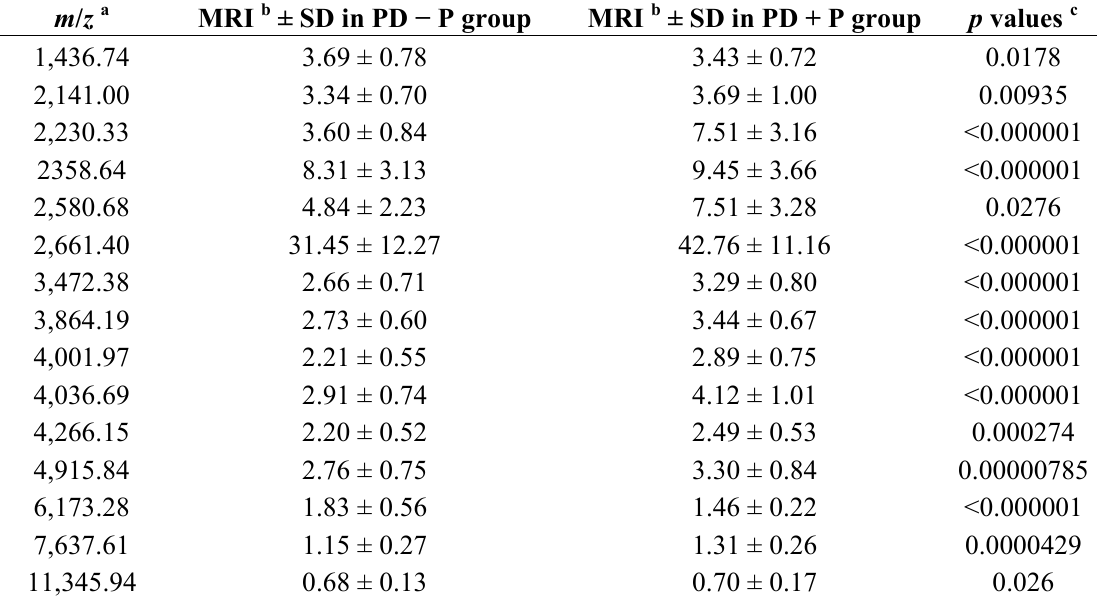
Table 5. PDE peptide peaks included in the genetic algorithm (GA)-based model to distinguish peritonitis patients from normal controls.